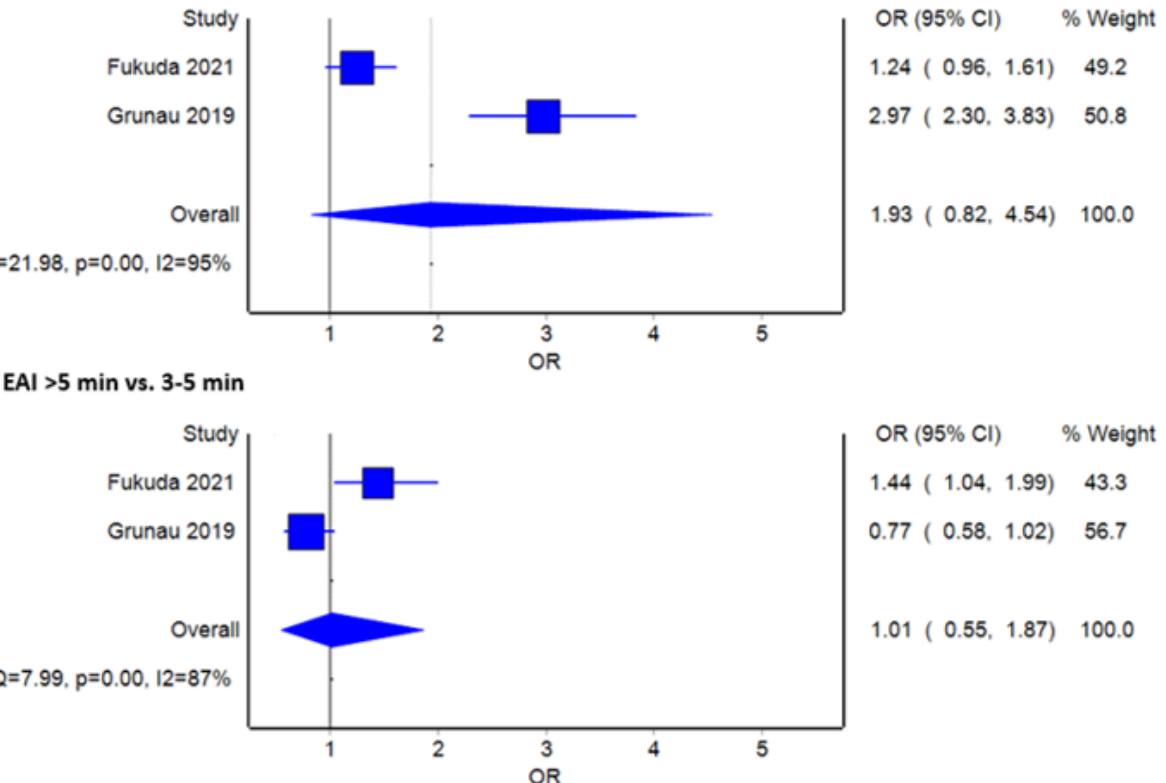
Figure 2. Forest plots comparing favorable neurological status at hospital discharge between standard epinephrine administration interval (every 3–5 min) and ( a ) <3 min or ( b ) >5 min using inverse variance heterogeneity model.